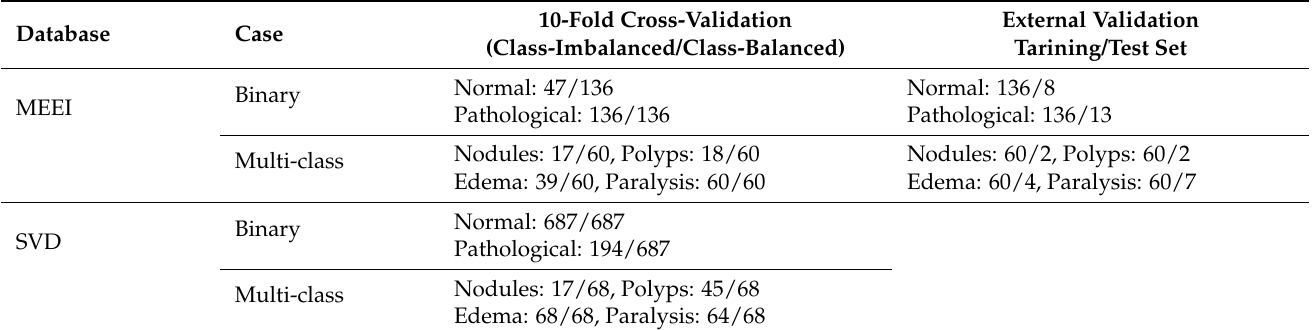
Table 4. Number of samples of the experimental